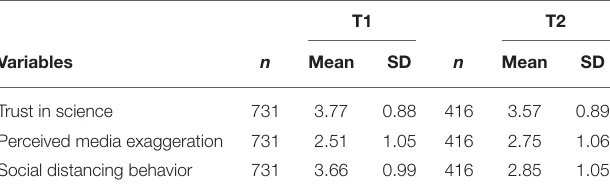
TABLE 3 | Mean values and standard deviation of variables included in the SEM